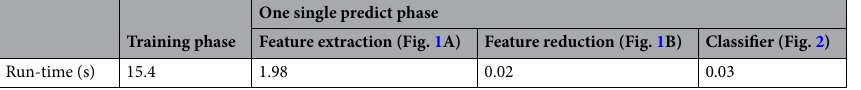
Table 2. Run-time analysis on the local system with the CPU of Intel Core i7-8750H 2.2 GHz and GPU of RTX2080